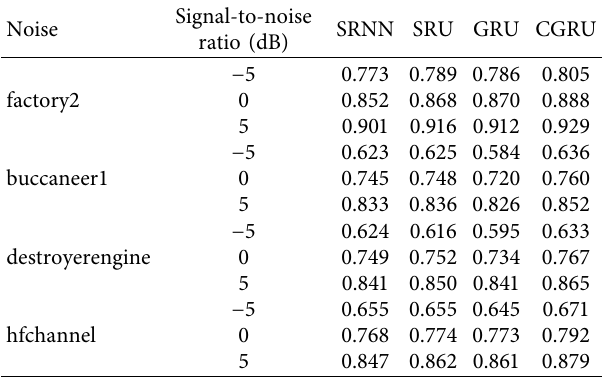
Table 2: Average Short-Term Objective Intelligibility of Speech